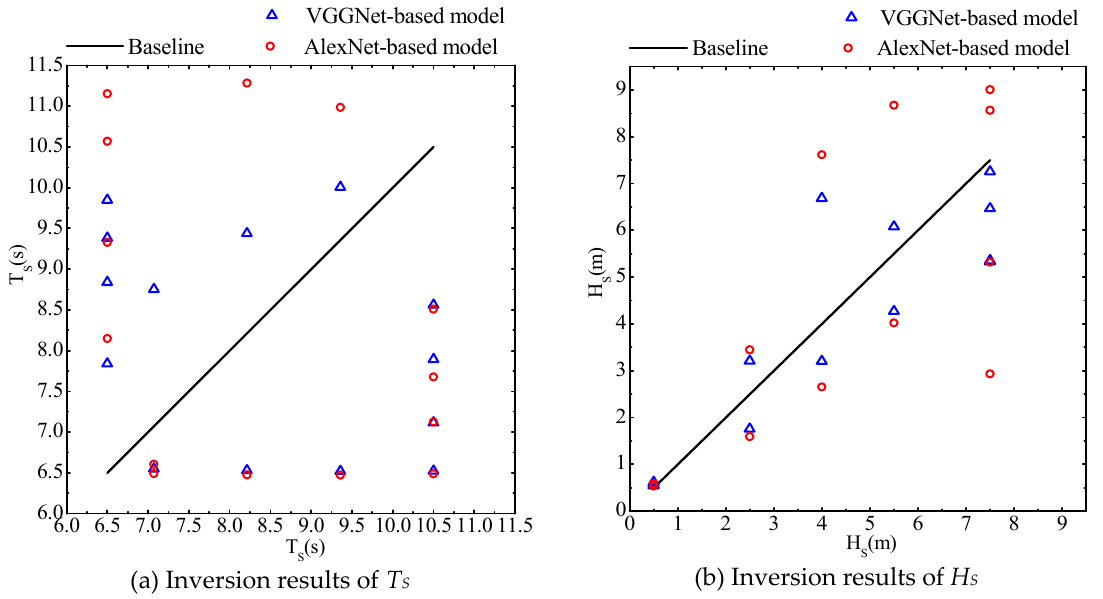
Figure 8. Inversion results of the CNN-based models trained by the initial training data set.